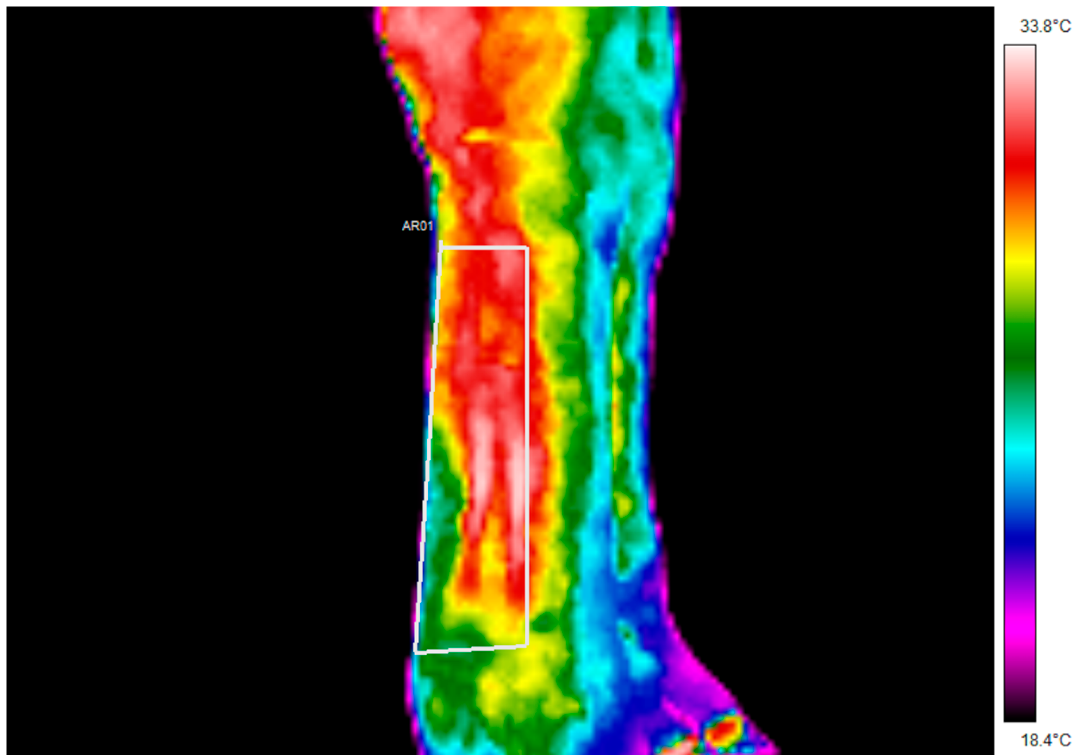
Figure 1. An example of the image of the right lateral forelimb of a subject using infrared thermography. The white frame (AR01) used to create regions of interest includes the palmar aspect of the distal limb, from the top of the third metacarpal bone to just above the proximal sesamoid bone. Basal measurements (AM) were recorded in each horse’s stable between 06.00–07.00